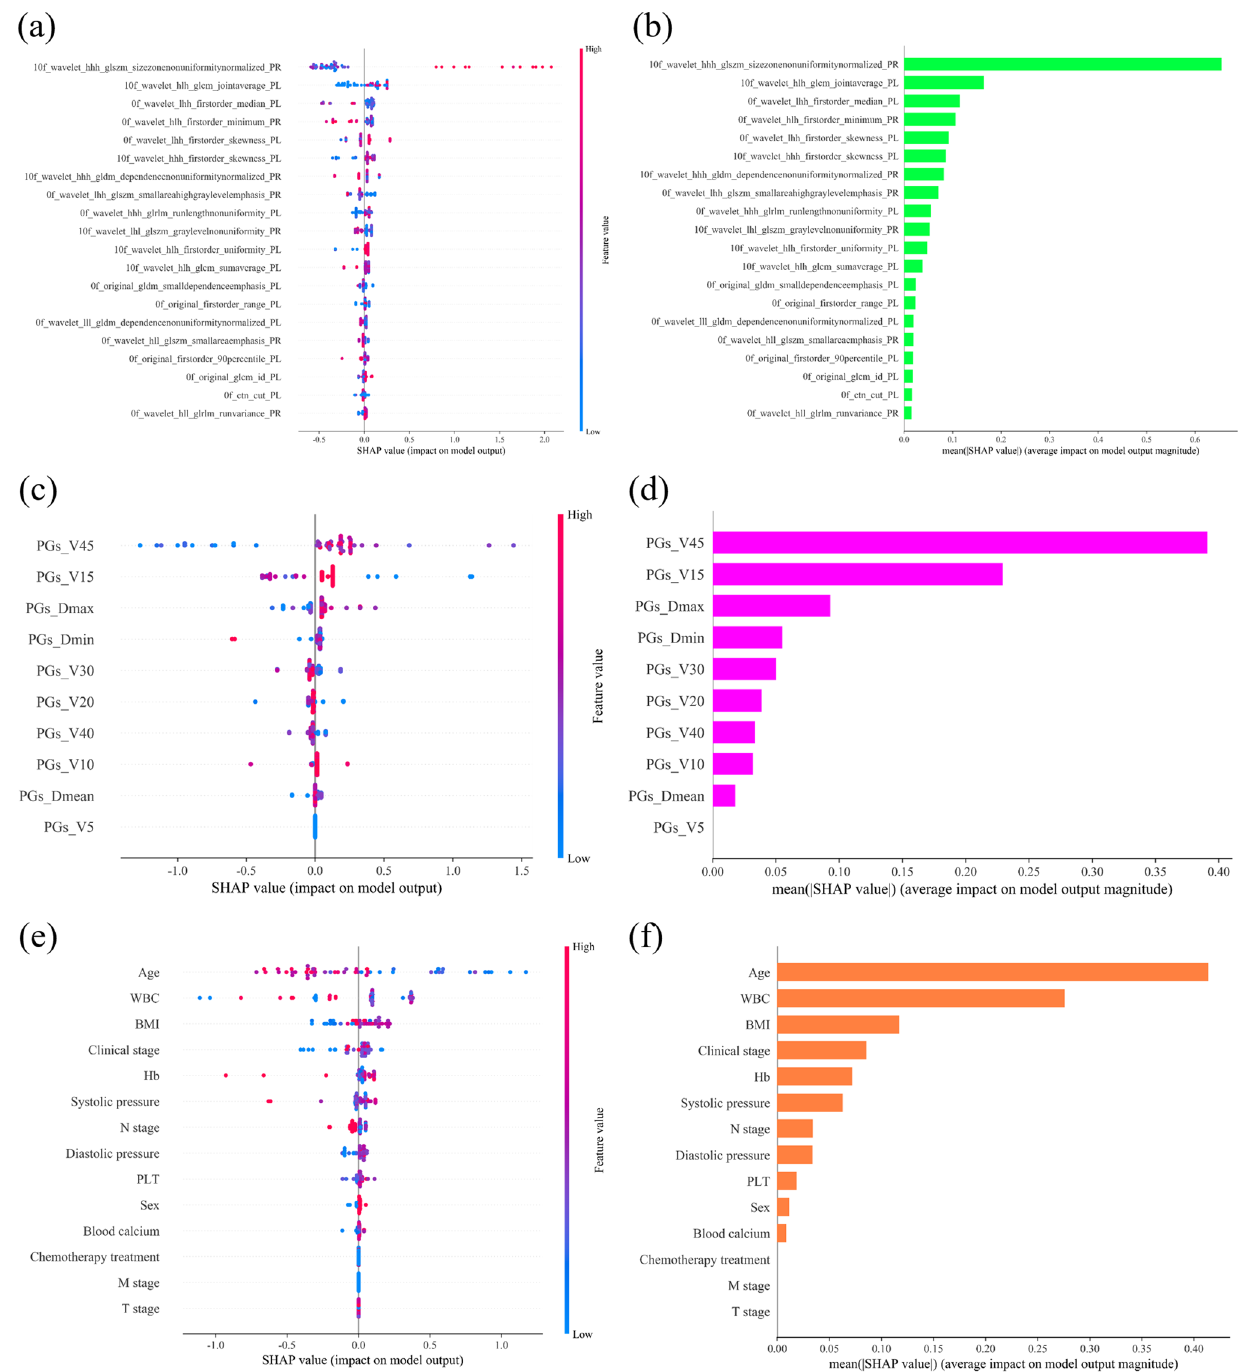
Fig. 2 SHAP Analysis of Radiomics, DVH criteria, and Clinical Features. a Distribution of SHAP values for radiomic features; b Ranking of SHAP values for radiomic features; c Distribution of SHAP values for DVH criteria features; d Ranking of SHAP values for DVH criteria fea- tures; e Distribution of SHAP values for clinical features; f Ranking of SHAP values for clinical features; a , b , ‘0f_’, ‘10f_’respectively mean the radiomics features extracted from 0 th fraction CT and 10 th fraction CT. ‘PL’ and ‘PR’ respectively mean the left parotid gland and right parotid gland. WBC white blood cell, Hb hemoglobin, PLT In Fig. 2. (c), for PGs_V45, the blue dots are clustered to the left of the longitudinal axis. Blue indicates that the sample has a small value of PGs_V45. The points to the left of the axis all have SHAP values less than zero, indicating that they have the negative effect on the prediction. Therefore, it can be concluded that PGs_V45 ↓ , (SA0f–SA30f) ↓ , SA30f ↑ , severity of